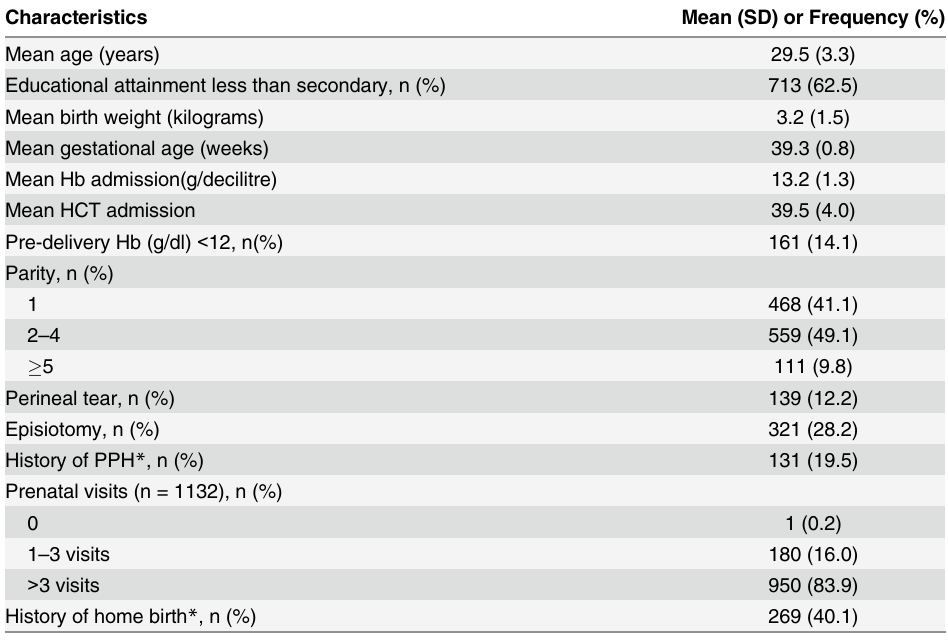
Table 1. Participant baseline demographic and clinical characteristics.